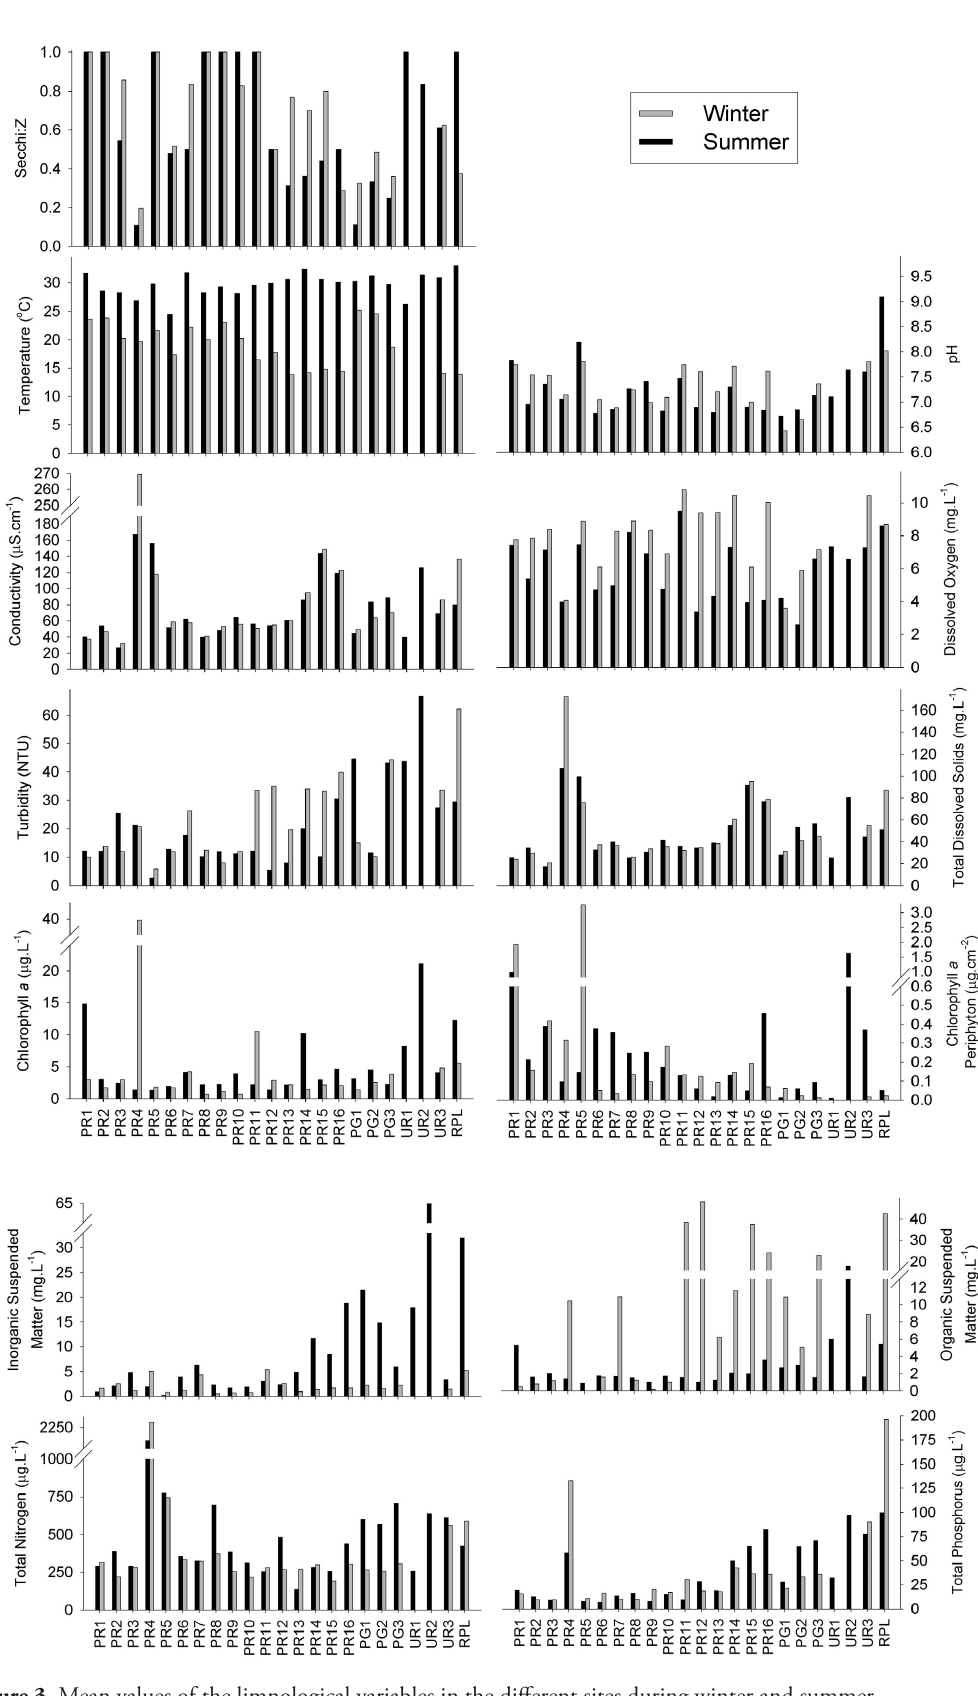
Figure 3. Mean values of the limnological variables in the different sites during winter and